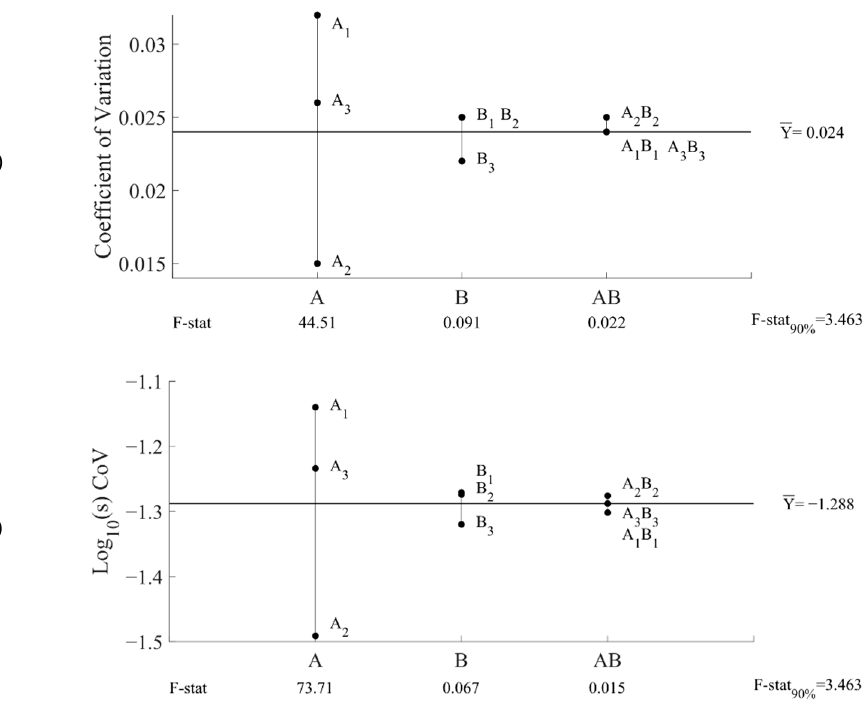
Figure 5. Laminates with concave corner represent ( a ) thickness coefficient of variation and ( b ) variability in the results.